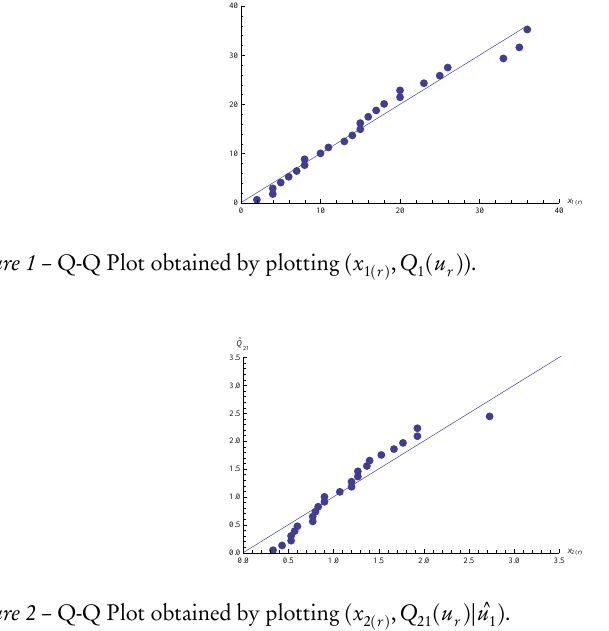
Figure 2 – Q-Q Plot obtained by plotting ( x